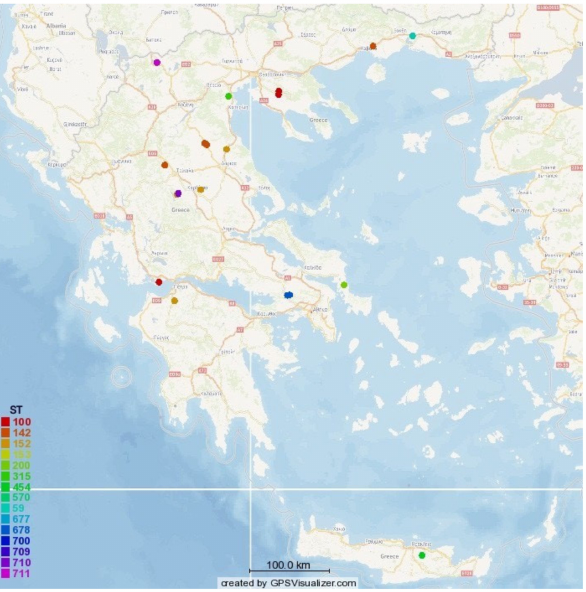
Figure 6. Map of Greece indicating the location of sheep farms where 33 S. epidermidis isolates from cases of ovine mastitis were recovered, according to the ST of the isolates (drawn by using the GPS-visualiser). ST: sequence type; GPS: Global Positioning